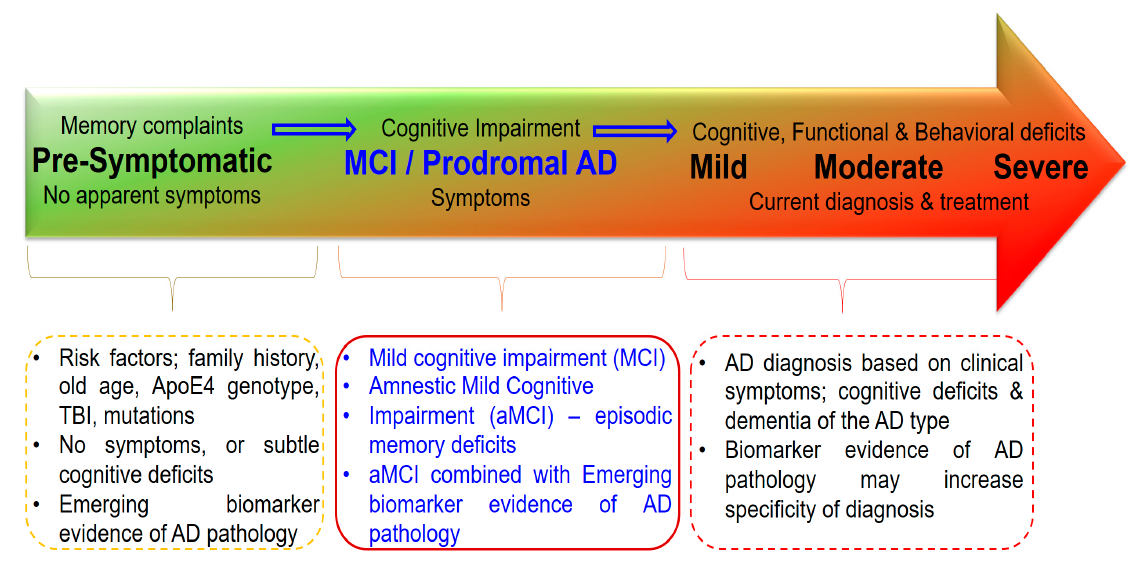
Figure 2. Progression from normal aging to Alzheimer’s disease or another dementia.